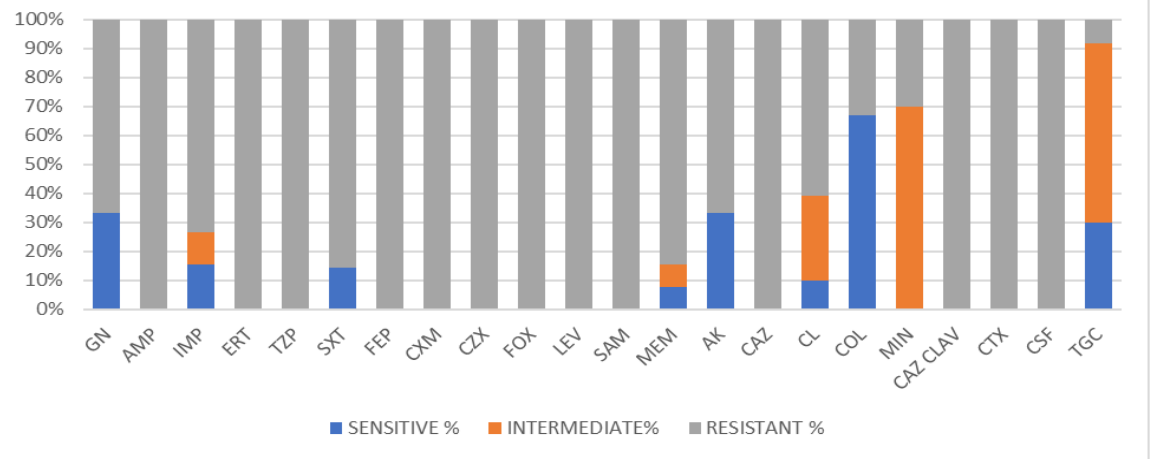
Figure 2. Shows the antibiotic susceptibility pattern for CPE